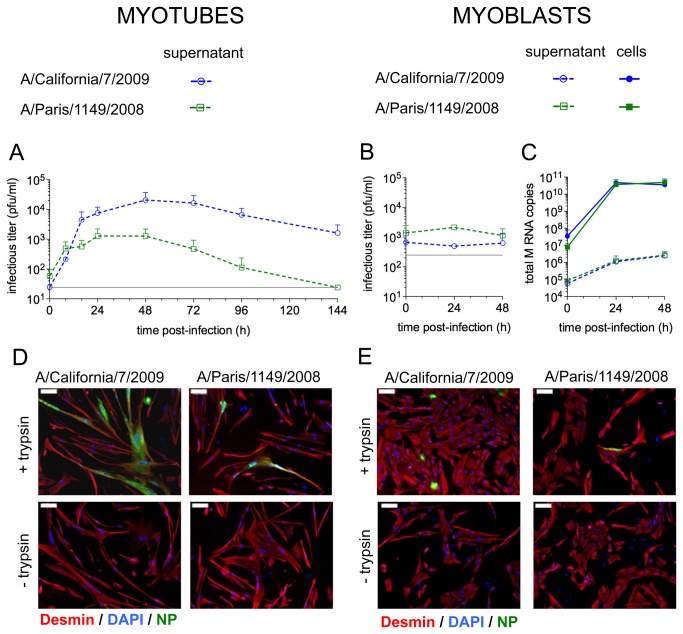
Kinetics of viral RNA and particle production by muscle cells.
A, B. The infectious titers in the supernatants of CHQ myotubes (A) or myoblasts (B) were measured by plaque assay at various time points after infection with the A/California/7/2009 (blue lines) or the A/Paris/1149/2008 (green lines) viruses. Data are the mean of 2 or 3 independent experiments with the standard deviation. The detection threshold (grey line) was 25 pfu/ml for myotubes and 250 pfu/ml for myoblasts. For this experiment, the concentration of serum in myoblasts’ medium, which could limit the efficiency of viral multiplication and the sensitivity of the plaque assay, was reduced to 5%.
C. The amount of total M RNAs was quantified by RT-qPCR in supernatants (dashed lines) and in cell extracts (solid lines) of CHQ myoblasts at various time points after infection with the A/California/7/2009 (blue lines) or the A/Paris/1149/2008 (green lines) viruses. Data are the mean of 2 independent experiments with the standard deviation.
D, E. Supernatant from myotubes were harvested 48h after infection with the A/California/7/2009 or the A/Paris/1149/2008 isolates, incubated with or without TPCK-trypsin, and used to infect myotubes (D) and myoblasts (E) from the same donor (CHQ). Indirect immunofluorescence detection of desmin (red) and NP (green) and staining of the nuclei with DAPI (blue) were performed. Bar: 100µm.